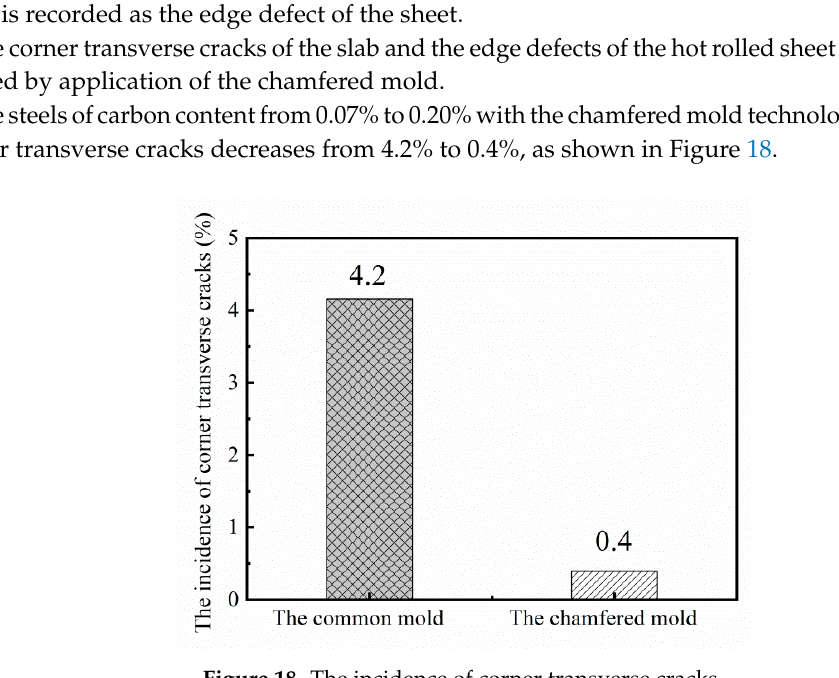
Figure 18. The incidence of corner transverse cracks.